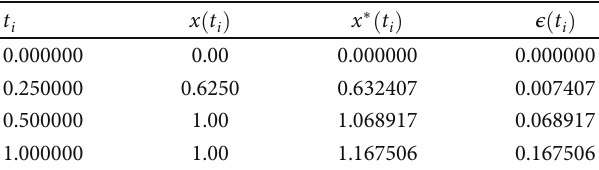
Table 1: Values at some point in the interval ½ 0, 1 